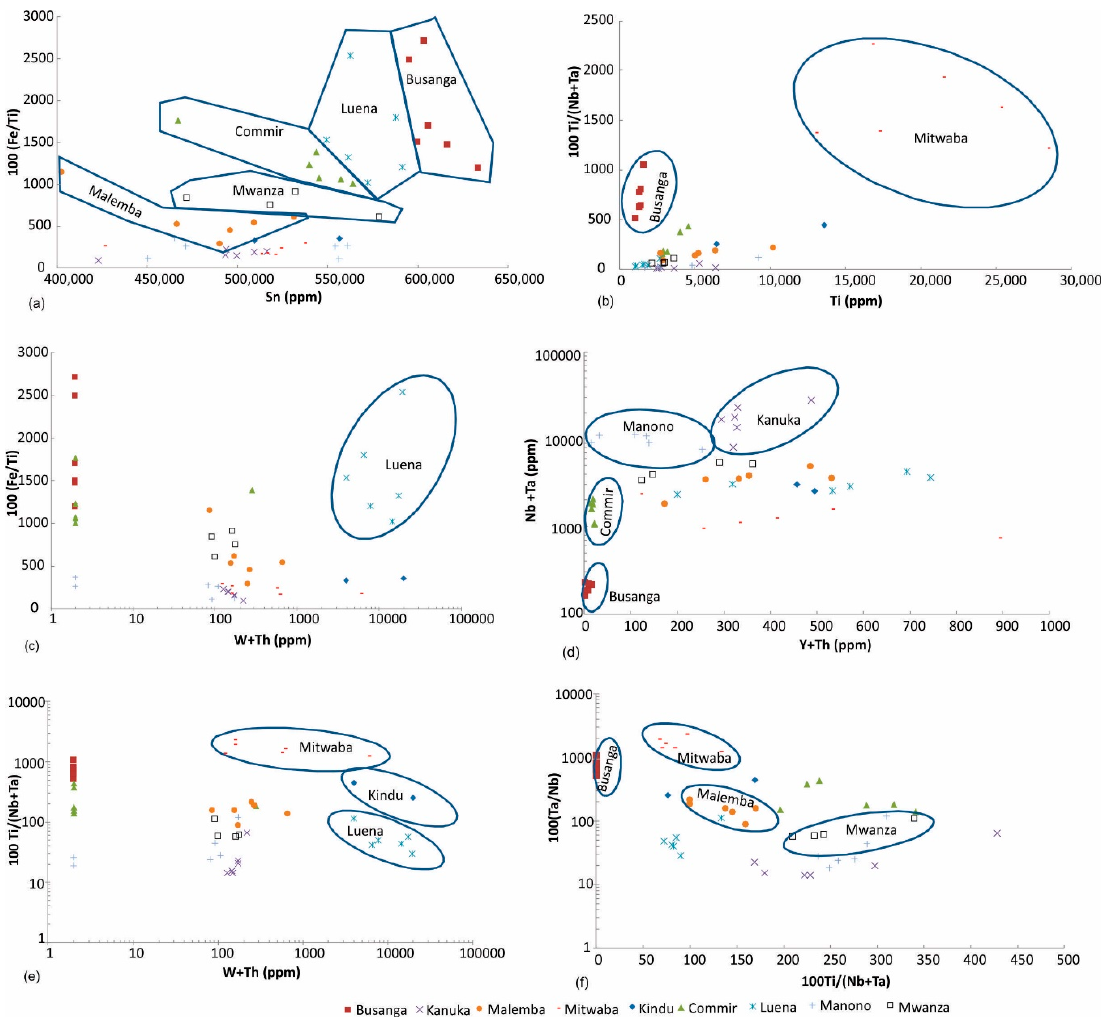
Figure 5. Discrimination of ( a ) Malemba, Mwanza, Commir, Luena, and Busanga, ( b ) Mitwaba and Busanga, ( c ) Luena, ( d ) Busanga, Commir, Manono, and Kanuka, ( e ) Mitwaba, Kindu, and Luena, ( f ) Busanga, Mitwaba, Malemba, and Mwanza cassiterite ore samples.